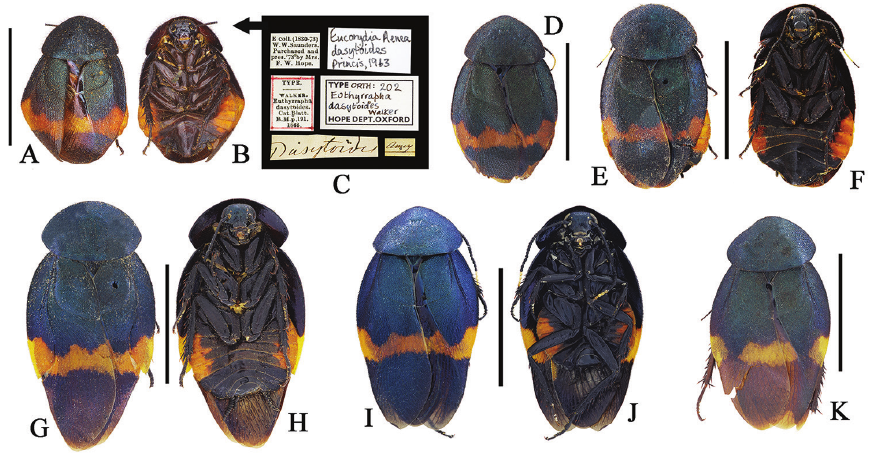
Figure 2. A–K Eucorydia dasytoides , the type population A–C holotype of Euthyrrhapha dasytoides : A–B habitus, female C label [A–C photographed by Katherine Child and provided by Amoret Spooner, copyright Oxford University Museum of Natural History, Oxford (OUM)] D female, from Huaihua, Hu- nan E–F female, from Mt. Fanjingshan, Guizhou G–H male, from Mt. Hupingshan, Hunan I–J male, from Zhenyuan, Guizhou K male, from Yueyang, Hunan. Scale bars 10 mm.